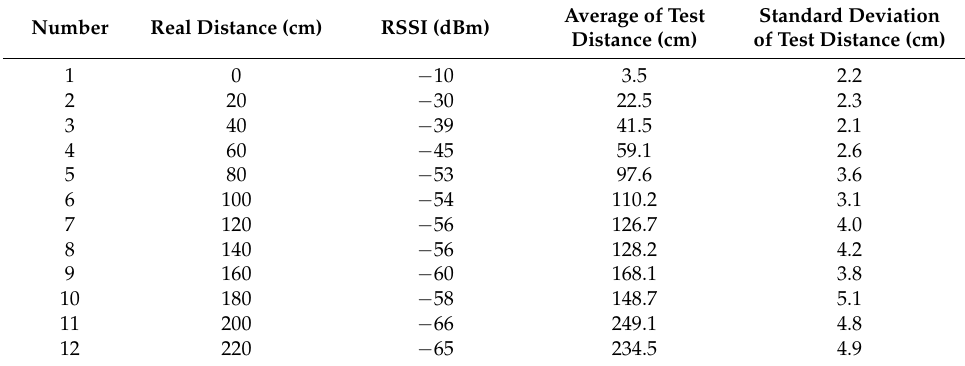
Table 3. RSSI localization